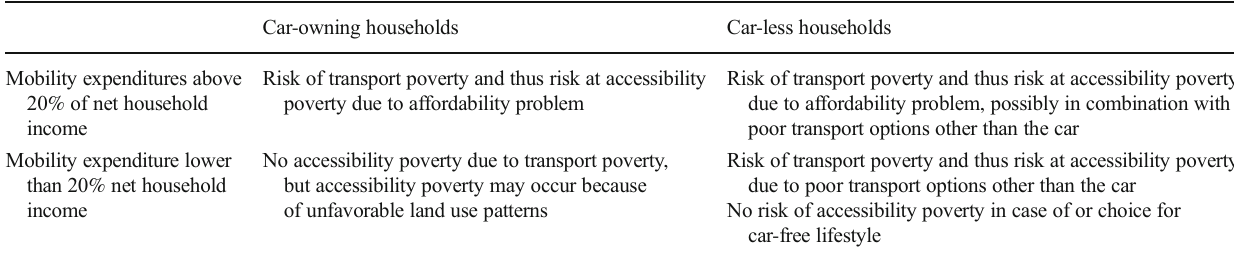
Types of transport poverty risks and related risks at accessibility poverty Car-owning households Car-less